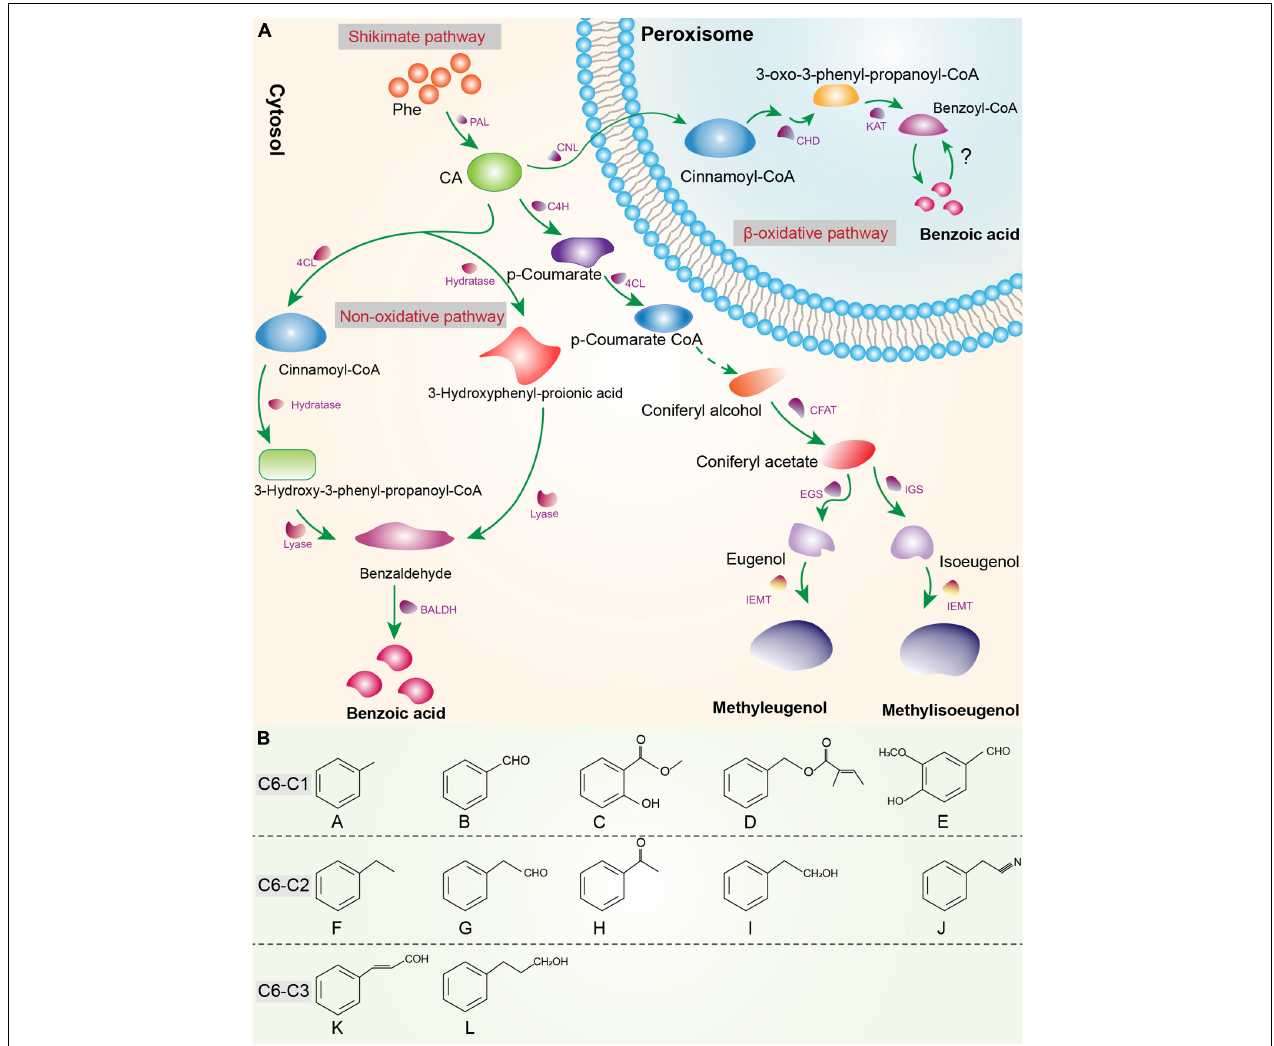
FIGURE 2 | (A) Phenylpropanoid and benzenoid biosynthesis. All shikimate pathway enzymes and intermediates in the cytosol and peroxisome are shown. BALDH, benzaldehyde dehydrogenase; CA, trans- cinnamate; CHD, cinnamoyl-CoA hydratase/dehydrogenase; CFAT, coniferyl alcohol acyltransferase; C4H, cinnamate 4-hydroxylase; CNL, cinnamate-CoA ligase; 4CL, 4-hydroxycinnamoyl CoA ligase; EGS, eugenol synthase; IEMT, isoeugenol O -methyltransferase; IGS, isoeugenol synthase; PAL, phenylalanine ammonia lyase; KAT, 3-ketoacyl thiolase 1. (B) Chemical structures of benzenoid (C6–C1) compounds. A, methylbenzene; B, benzaldehyde; C, methyl 2-hydroxybenzoate (methyl salicylate); D, benzyl (£)-2-methyl-2-butenoate (benzyl tiglate); E, 4-hydroxy-3-methoxybenzaldehyde (vanillin). Phenylpropanoid-related (C6–C2) compounds: F, ethylbenzene; G, phenylacetaldehyde; H, acetophenone; I, 2-phenylethanol; J, 2-phenylacetonitrile. Phenylpropanoid (C6–C3) compounds: K (£)-cinnamic aldehyde; L,